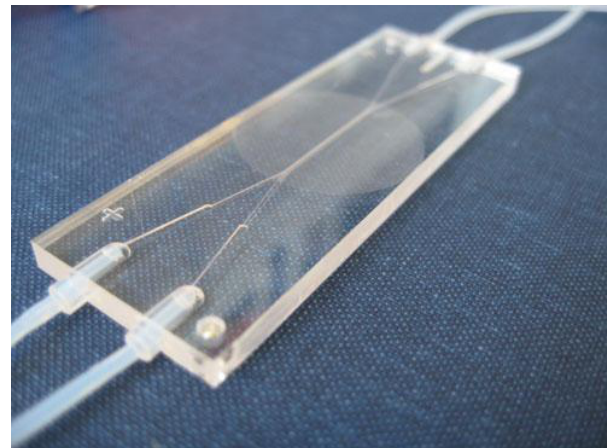
Figure 5. Microfluidic device for studies of chemotactic cell migration. The chip was fabricated in PMMA and contained separate channels for cells and chemoattractants. This type of assay has application in drug screening